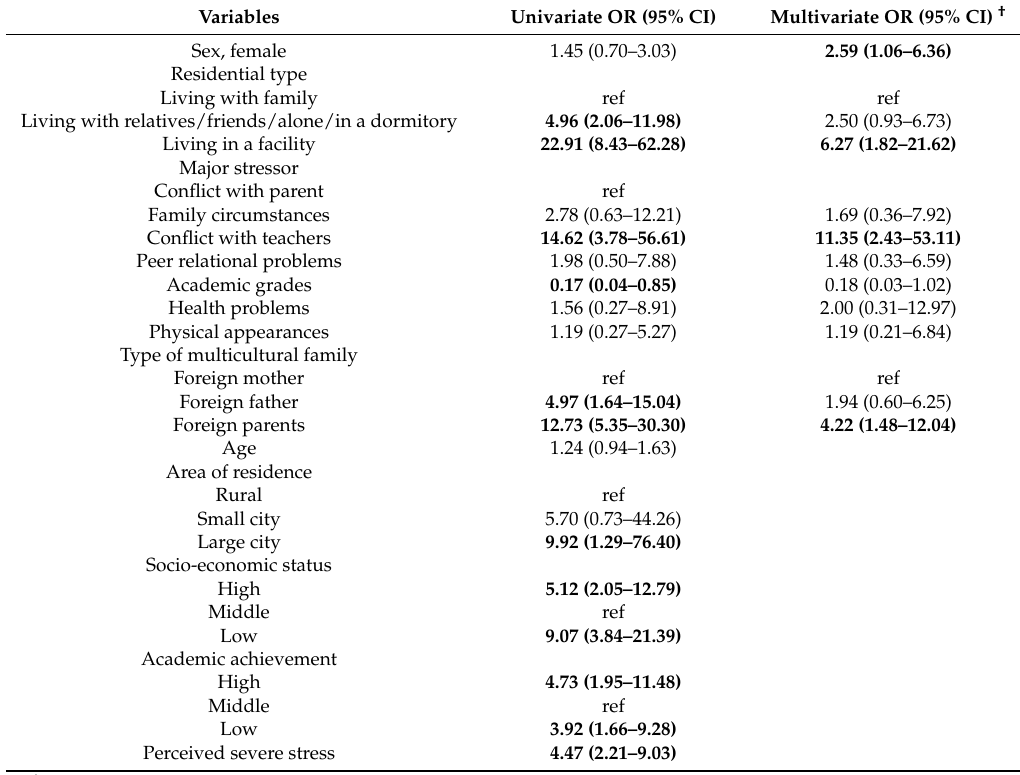
Table 3. Odds ratios of predictors for suicidal behaviors in the past year among adolescents in multicultural